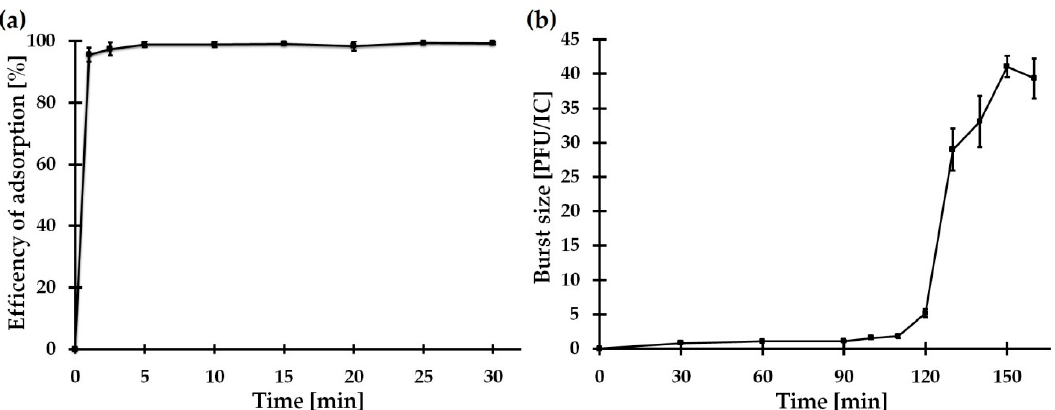
Figure 6. Phage BZS1 development. Adsorption of phage particles to the bacterial cells assessed after 1, 2.5, 5, 10, 15, and 30 min ( a ). One-step growth curve ( b ). Each data point represents the mean of three independent experiments.